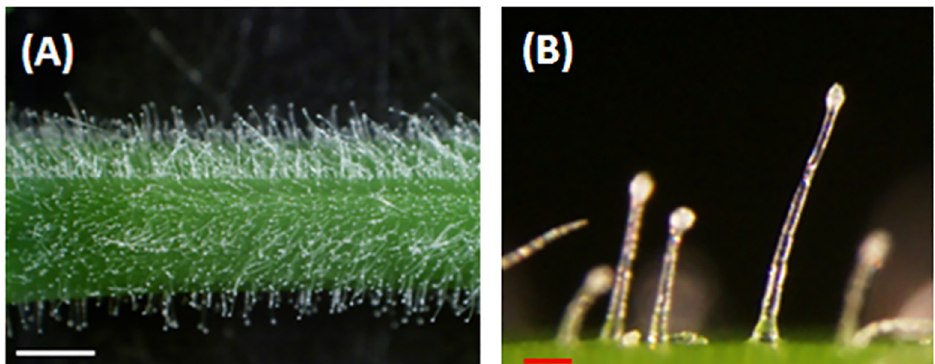
Figure 1. Alfalfa glandular trichomes. ( A ). Glandular trichomes on an alfalfa (FSG 420LH) stem. ( B ). Magnified view of glandular trichomes showing stalks and secretary heads. White bar = 1 mm, red bar = 0.1 mm.